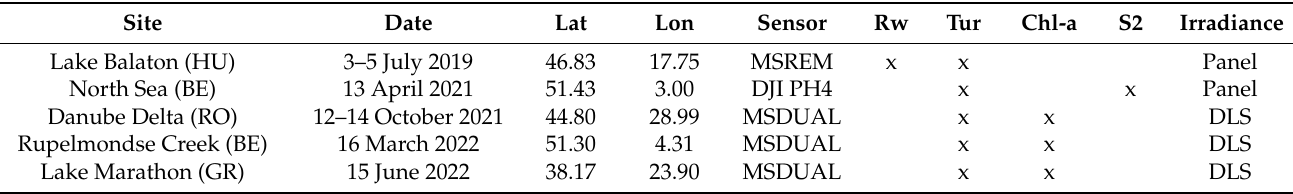
Table 2. Overview of drone flights: date, location and sensor are listed, as well as the in situ measurements used for validation. (DJI PH4 = DJI Phantom 4 Pro, MSREM = MicaSense RedEdge-M, MSDUAL = MicaSense Dual